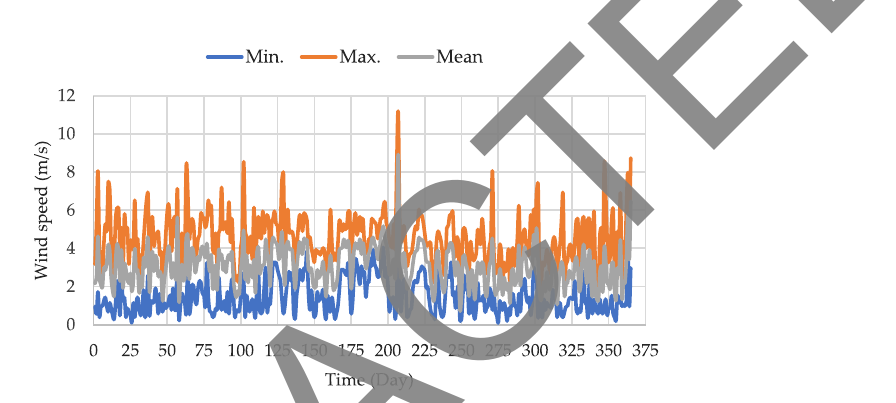
Fig. 6. Daily maximum, minimum, and mean wind speed variations for 2020 – 2021.